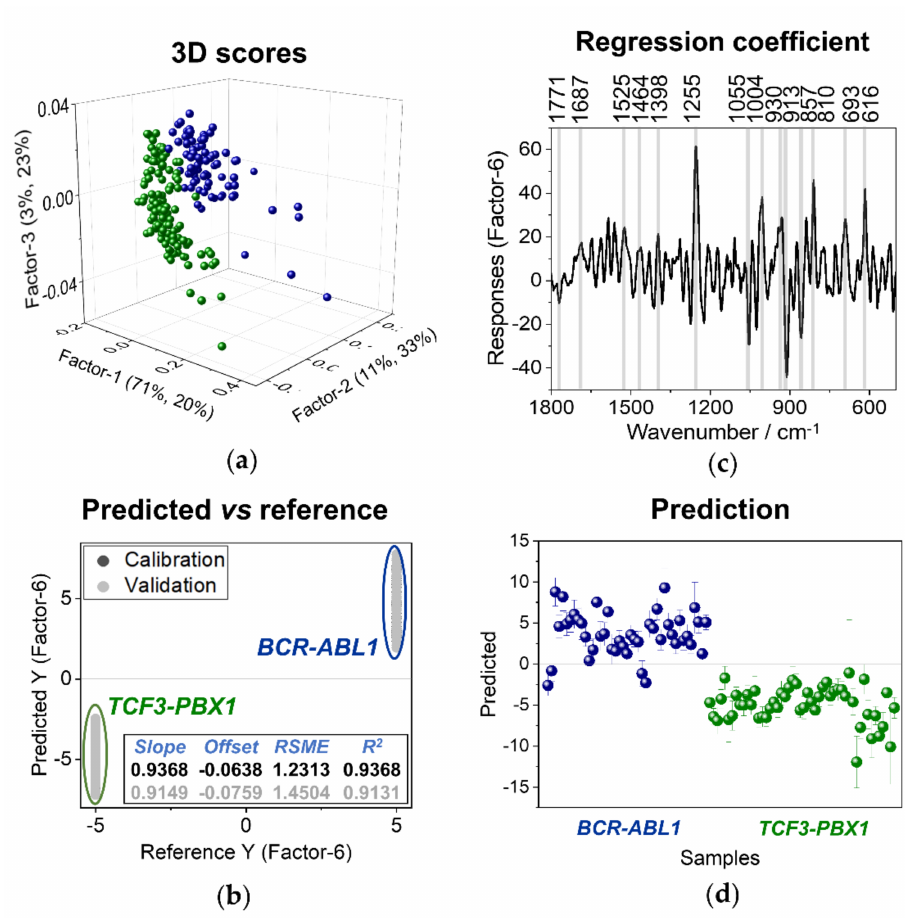
Figure 7. A PLS discriminant analysis. ( a ) Two-dimensional score plot for factors 1 and 2 of PLS-DA. ( b ) Results presenting calibration and validation of the model. ( c ) The regression coefficient of the training data set (two groups: BCR-ABL1 and TCF3-PBX1 ; n = 3 for each group). ( d ) Prediction results for the test data set ( n = 3 for each of the following groups: BCR-ABL1 and TCF3-PBX1 ). Data are obtained for the spectra of whole-cell clusters of two groups of leukemic cells ( n = 3 in total for each group); laser excitation of 633